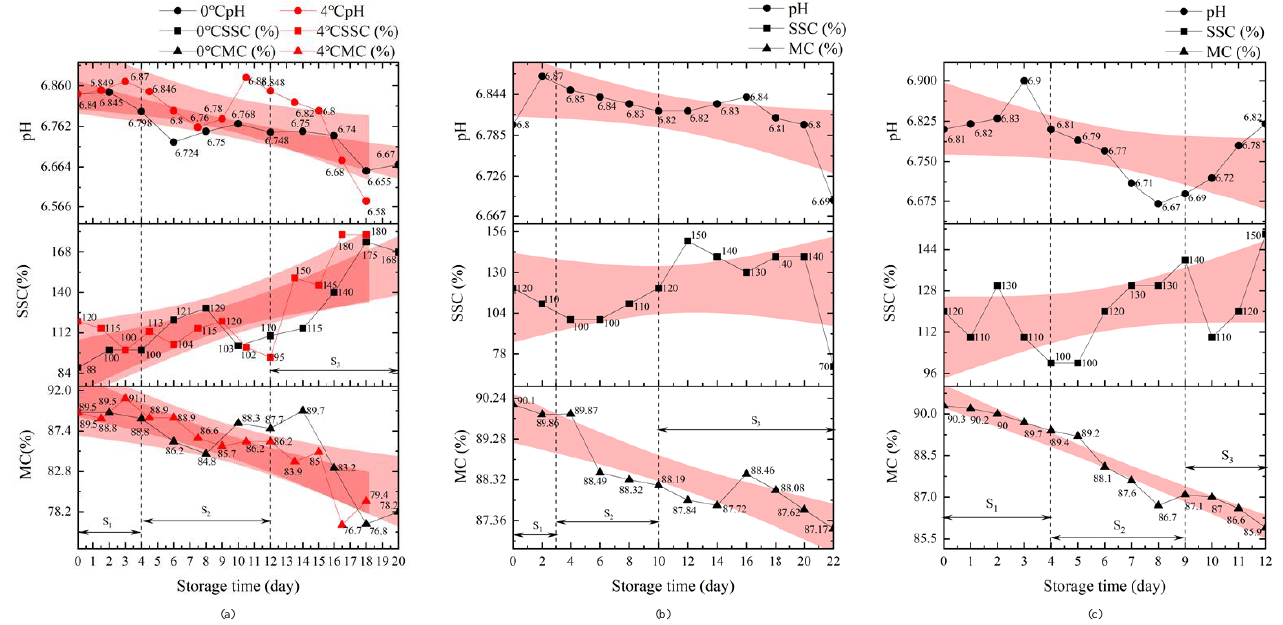
Figure 7. Characteristics chart of matsutake physicochemical indicator changes with the different packaging methods: ( a ) refrigeration preservation packaging at different temperatures; ( b ) modified atmosphere packaging; ( c ) preservative preservation packaging.